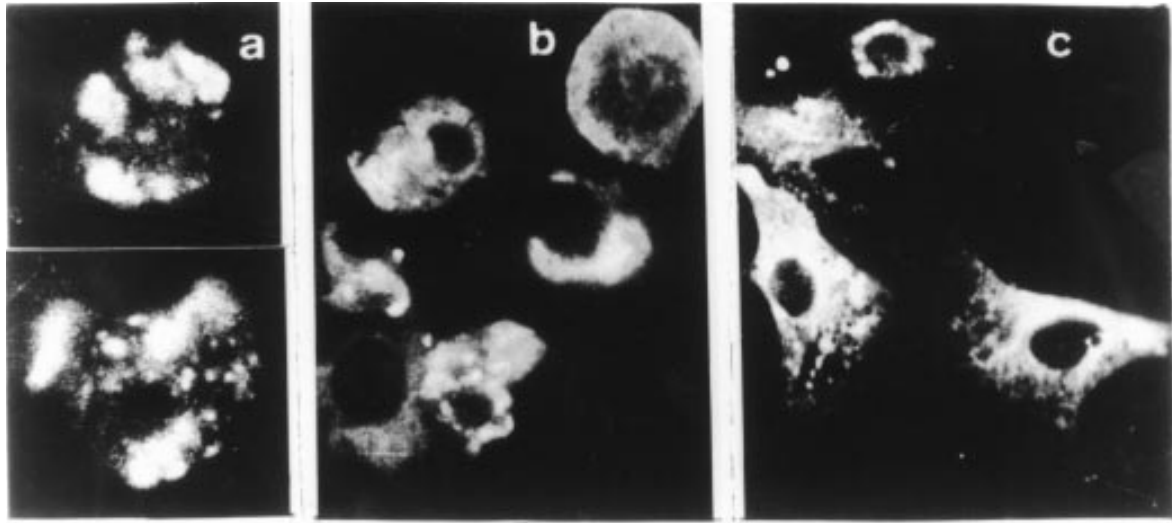
Figure 1 - Peritoneal phagocytic cells (a,b) and MA-104 cells (c) inoculated with rotavirus (a) and reovirus (b,c), and processed by immunofluorescence. a and b , 400X; c , 160X. Characteristic perinuclear fluorescent staining of the infected cells can be